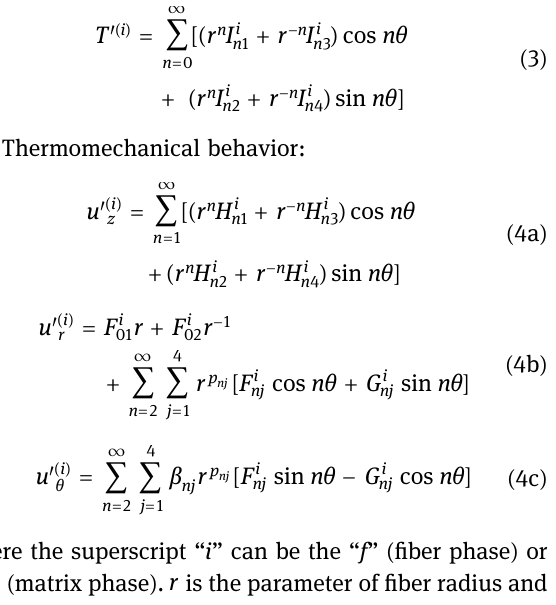
where x x x x , , 1 2 3 = ( ) and y y y y , , = ( ) are the upper - scale 1 2 3 homogenized and lower - scale localized coordinates, respec - tively. i = 1 is longitudinal direction, while i = 2,3 is transverse